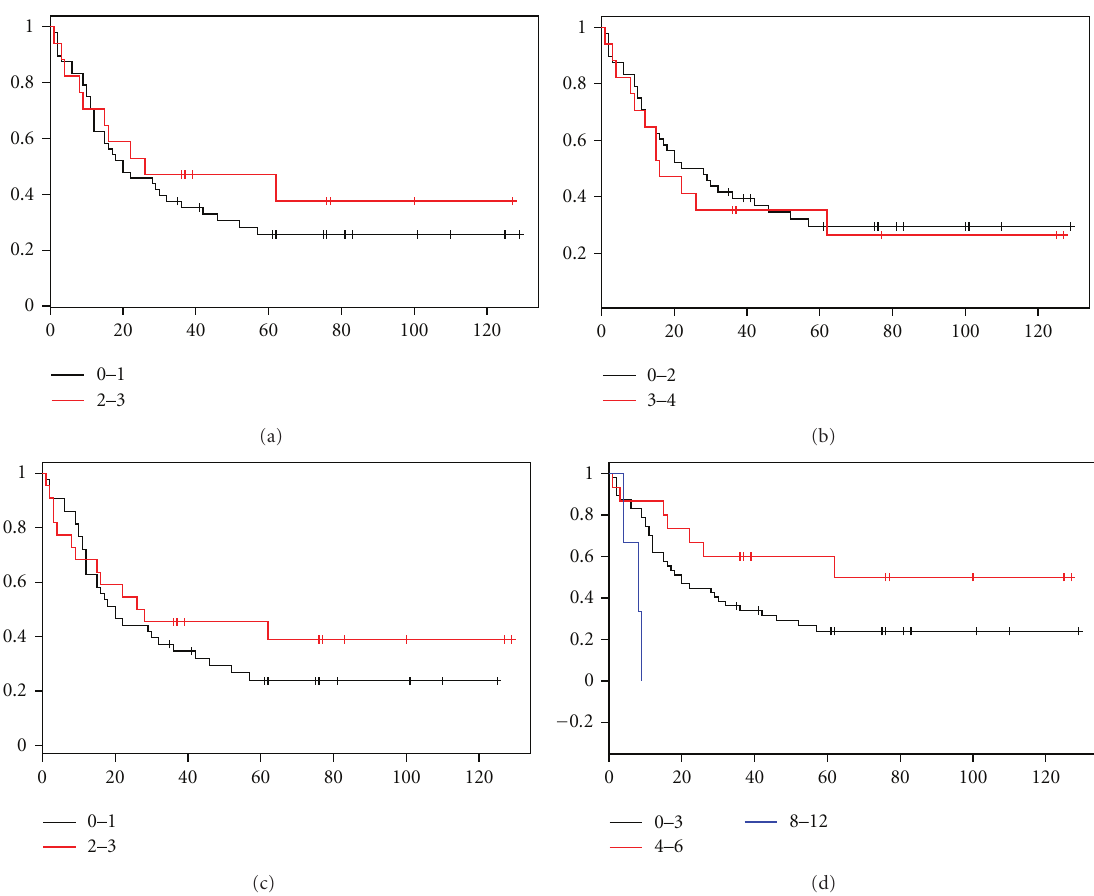
Figure 2: Kaplan-Meier curves for survival and expression of HER-2 in studied group of 78 gastric cancer patients: No correlation was observed between Hercep test score ( P = 0 . 454) (a), percentage of HER-2 positive gastric cancer cells ( P = 0 . 717) (b), intensity of immunohistochemical reaction ( P = 0 . 397) (c) and IRS rate ( P = 0 . 071) (d).